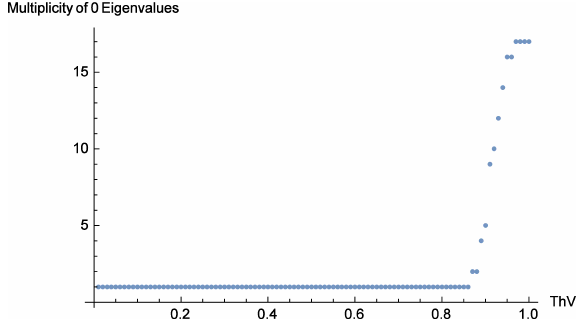
Fig. 1. The multiplicity of the 0 eigenvalues of each graph with respect to threshold values. For the threshold values bigger than 0.86, the number of components of graphs exponentially grows.